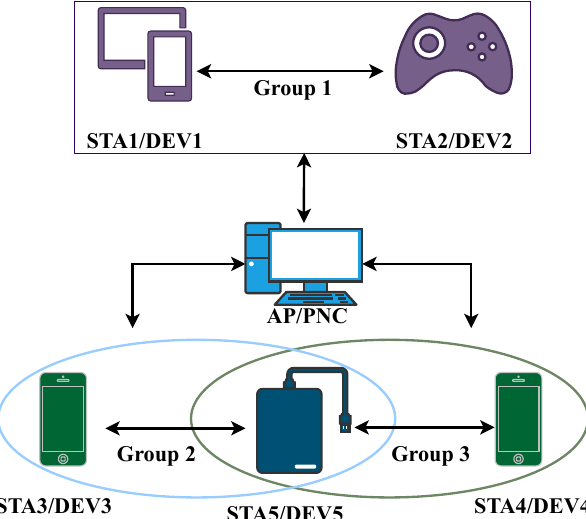
Figure 5. Operation of directive